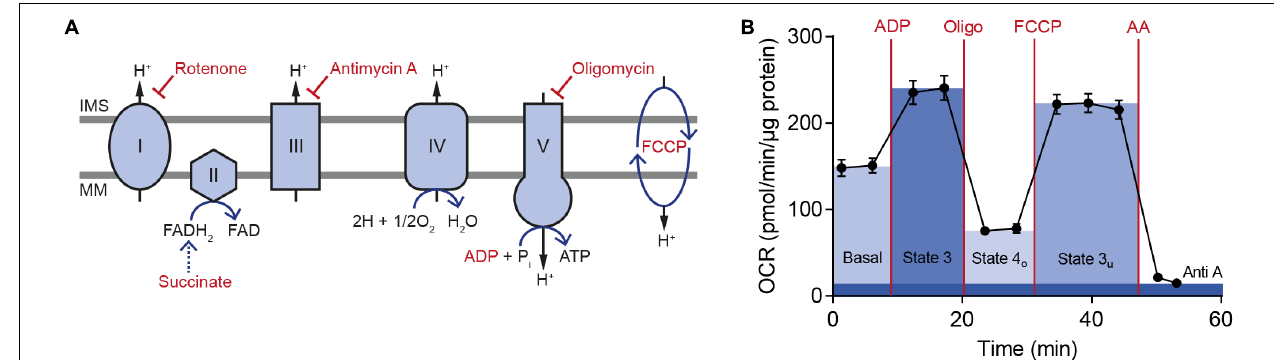
FIGURE 3 | Key steps in oxidative phosphorylation and representative oxygen consumption rate measurement with isolated mitochondria from rat brain. (A) The scheme illustrates the electron transport chain with its five different complexes. Modulating compounds used in the Seahorse mitochondrial coupling assay are highlighted in red. (B) An exemplary measurement of the oxygen consumption rate (OCR) from isolated rat brain mitochondria is shown together with key parameters of mitochondrial respiration, which were calculated from the data. Five technical replicates are displayed as mean ± SD. IMS, intermembrane space; MM, mitochondrial membrane; OCR, oxygen consumption rate; Oligo, oligomycin; AA, antimycin A.